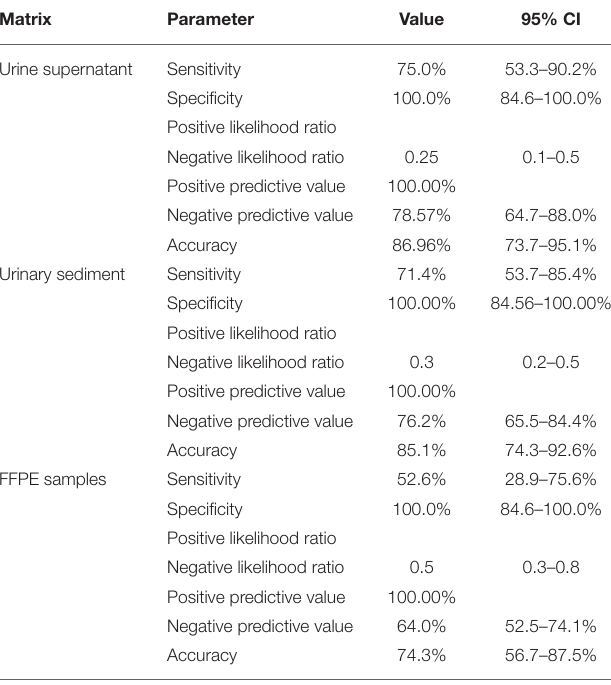
TABLE 1 | Results of the comparison between quantitative PCR and digital PCR as gold